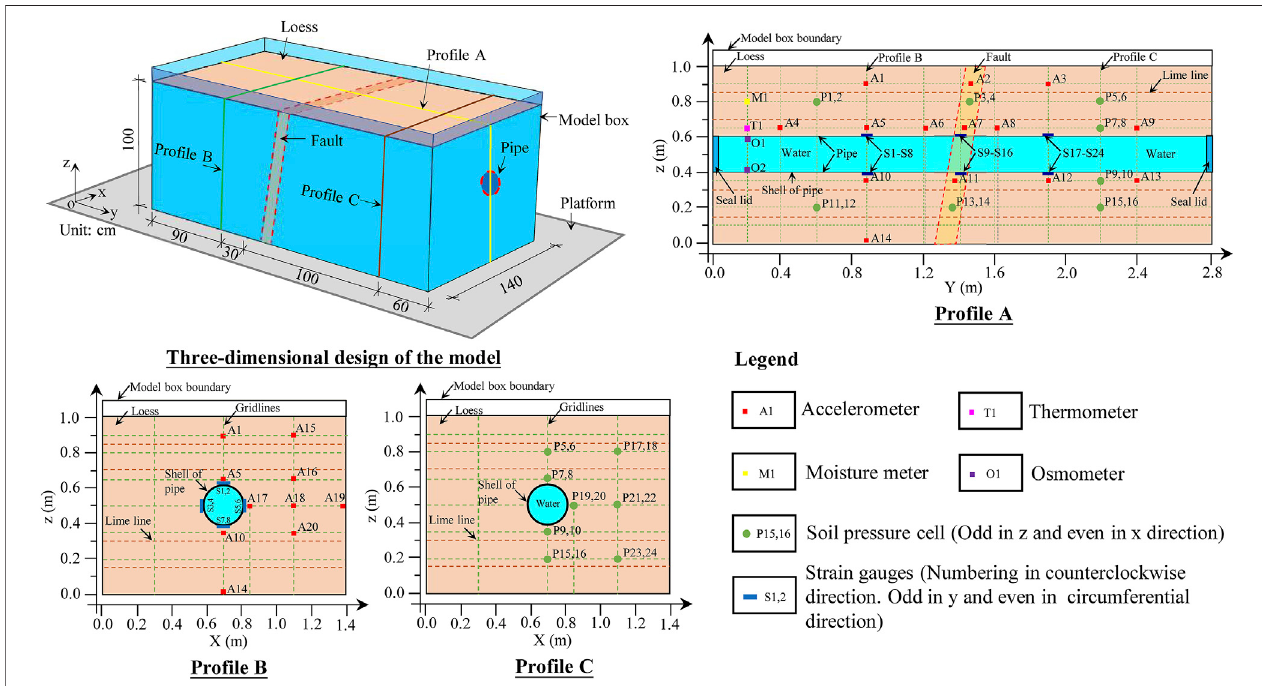
FIGURE 3 | Design and pro fi les of the vibration table